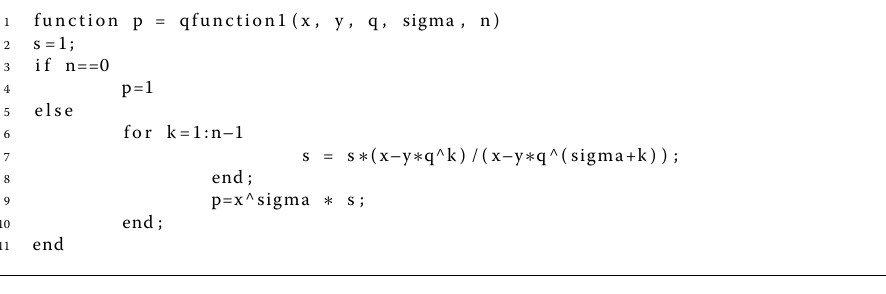
Algorithm 1 The proposed method for calculating ( x – y ) ( α ) q